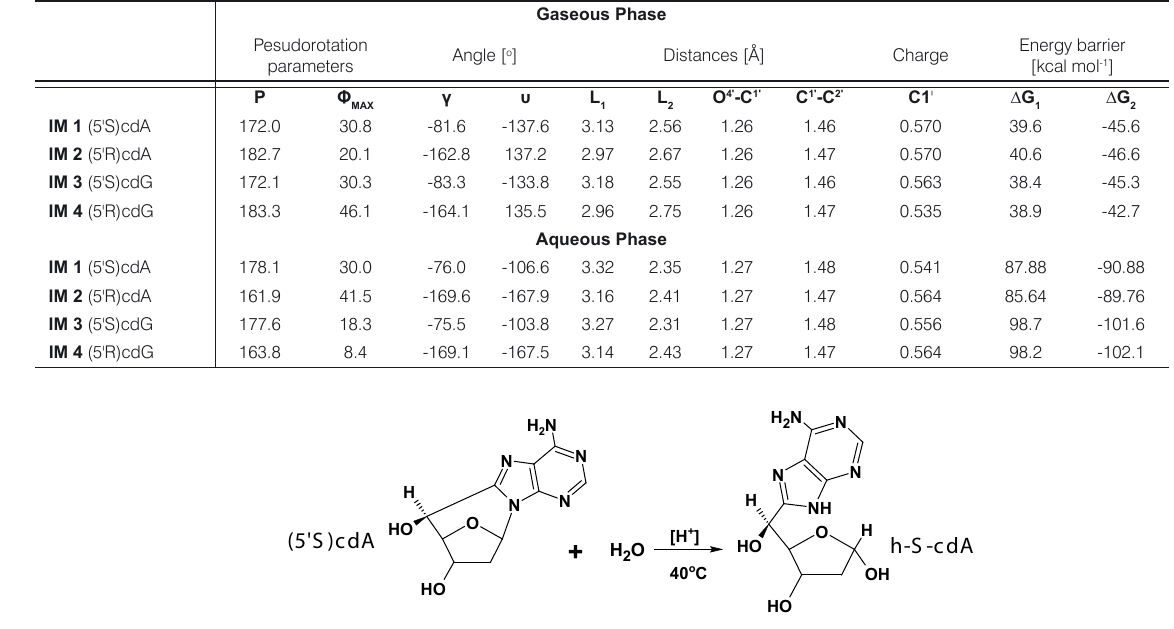
Table 3. The geometry details of short-lived oxacarbenium ion intermediate (IM), NPA charge analysis and the “energy barrier” : substrate → IM ( ∆ G